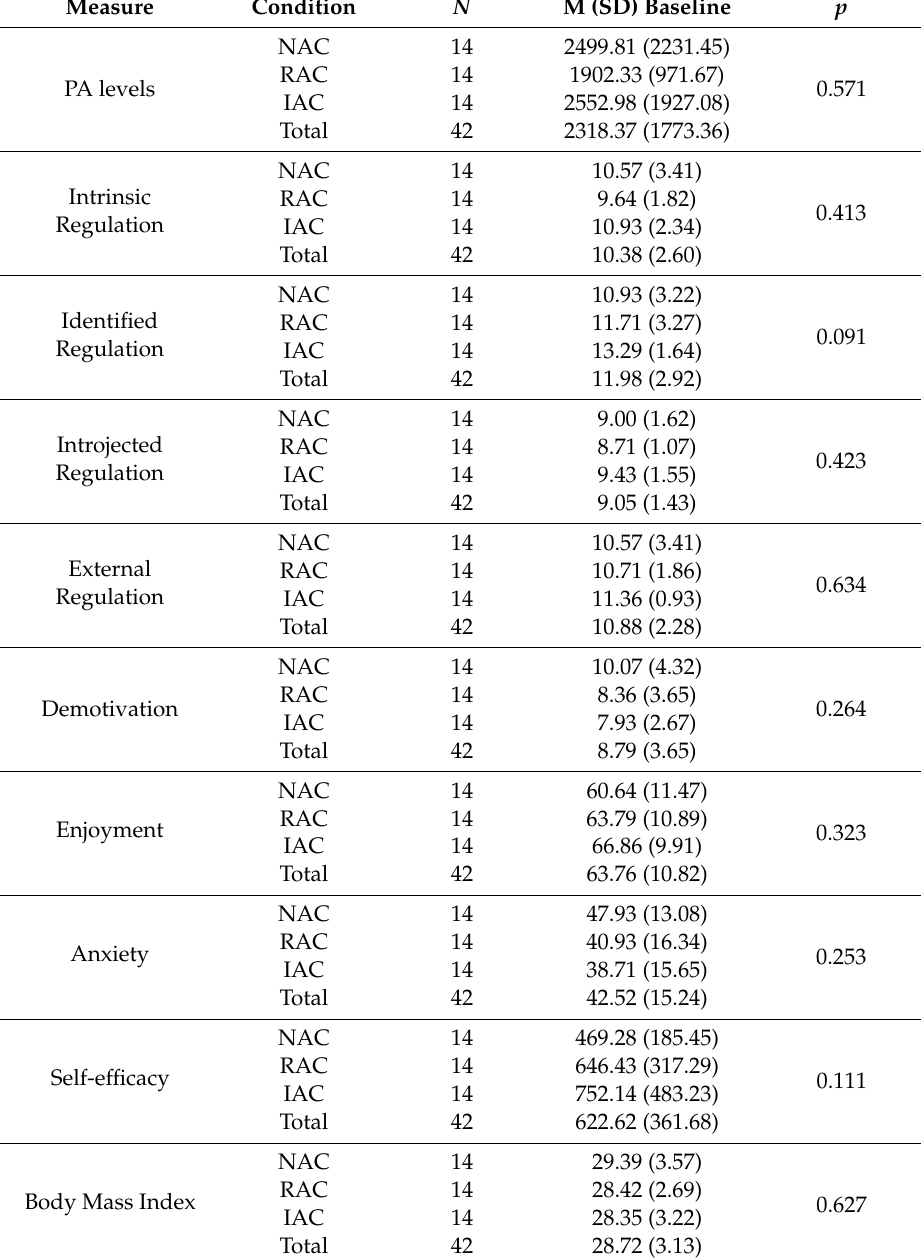
Table 1. ANOVA results for baseline measures and intervention